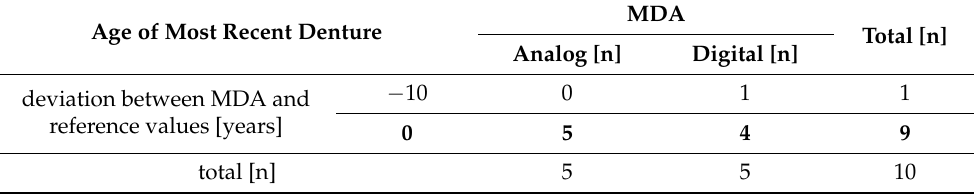
Table 4. Results for the “age of most recent denture”—deviation between the MDA and reference values for the analog (n = 5) and digital (n = 5) MDA. The absence of deviation from the reference value is shown in bold type.